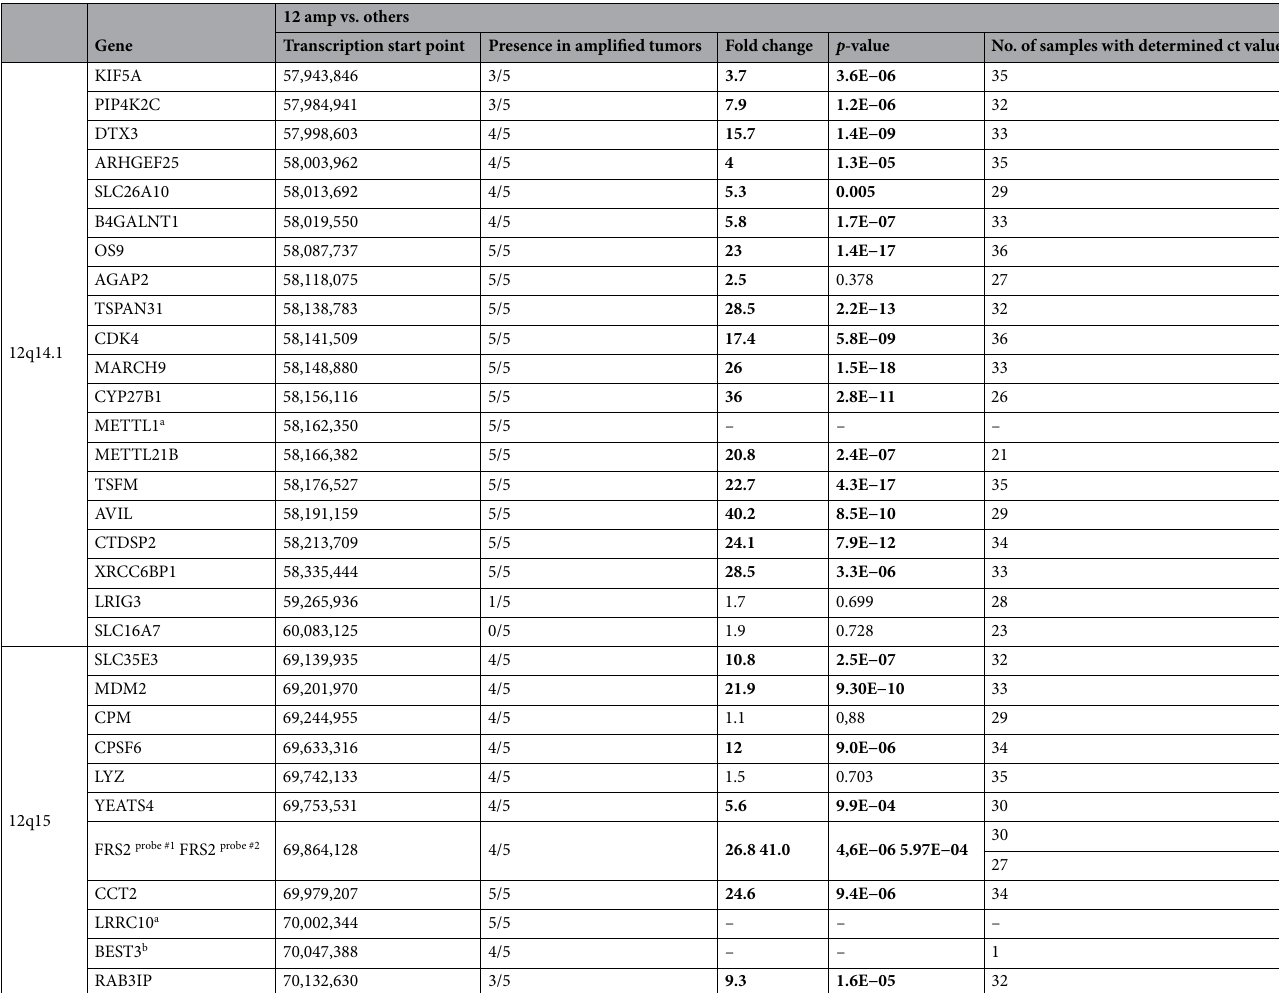
Table 2. Gene expression analysis of genes in amplified regions. Bold letters indicate a fold change greater than 2 or a p-value less than 0.05. a No probes available; b Determinable Ct value in only one